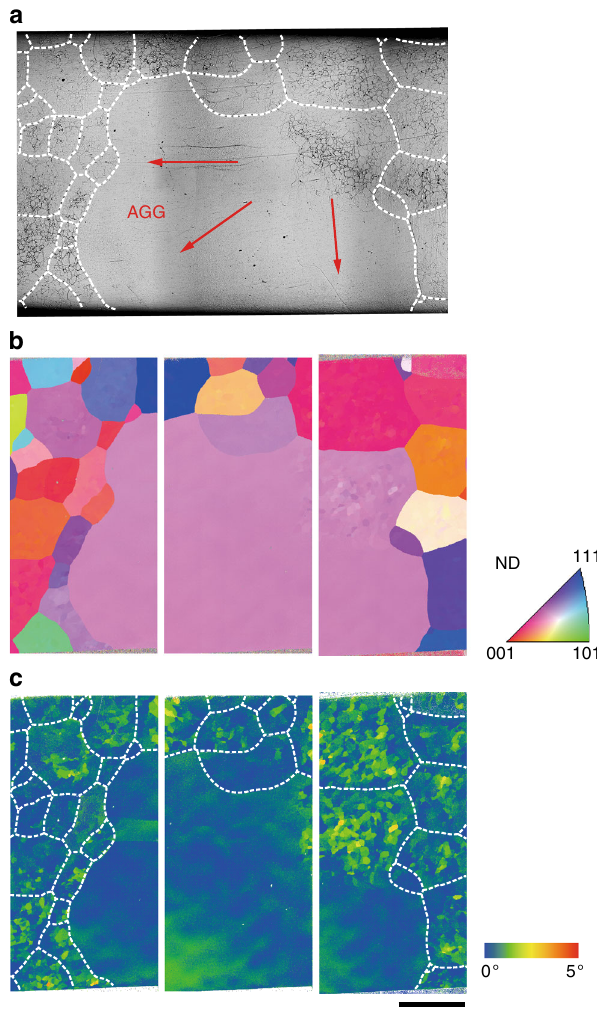
Fig. 2 Microstructure of Cu-Al-Mn alloy during abnormal grain growth (AGG). a Optical micrograph of Cu-Al-Mn sheet quenched from 900°C in the heating process after cooling from 900 to 500 °C (Supplementary Fig. 4a). The dashed lines indicate high-angle boundaries. b Inverse pole fi gure (IPF) mapping. The color means the crystal direction with respect to the normal direction of the sheet and corresponds to crystal direction given in the stereographic triangle. c Grain reference orientation deviation (GROD) mapping calculated as the misorientation angle with respect to a reference orientation (average orientation of a grain) in each grain. The dashed lines indicate high-angle boundaries. Scale bar , 1